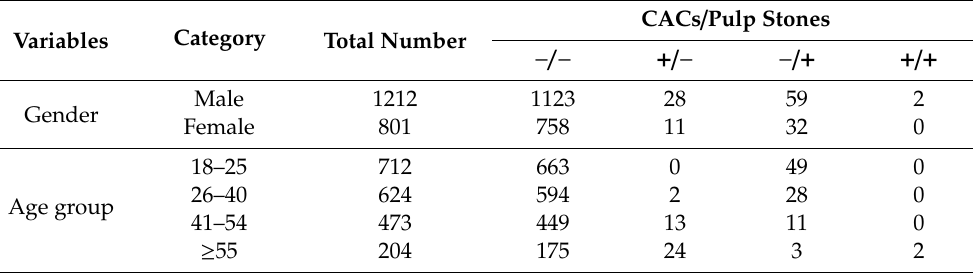
Table 3. Descriptive analysis of study variables and the association between pulp stones and carotid calcifications (CACs) ( n =